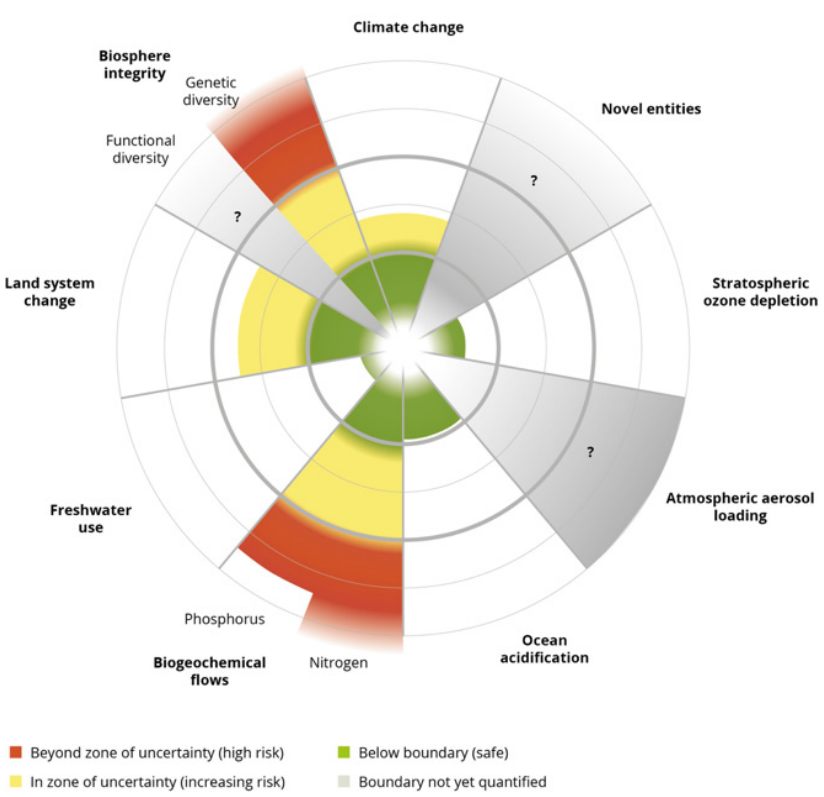
Figure 1. Status of the nine planetary boundaries, 2020 (https://www.eea.europa.eu/soer/2020/soer-2020-visuals/status-of-the-nine-planetary-boundaries/view, accessed on 15 October 2021). Other factors, such as stratospheric ozone depletion, ocean acidification, and freshwa- ter use, are all under pressure but still within the boundaries, according to the assessment of the Stockholm Resilience Centre in 2015 [2]. Finally, there is uncertainty regarding the status of two elements, novel entities and atmospheric aerosol loading, relative to the planetary boundaries, because it is either not clear where the planetary boundary lies (aerosol loading); it is not clear how much of the elements is present (novel entities); or it is not clear how the elements are impacting the natural environment